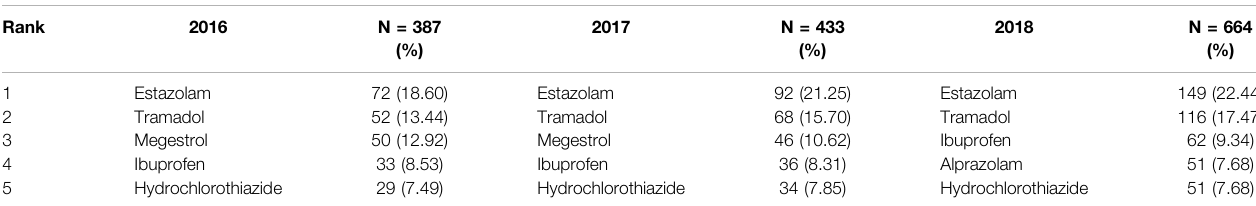
TABLE 3 | The top fi ve PIMs used by older lung cancer